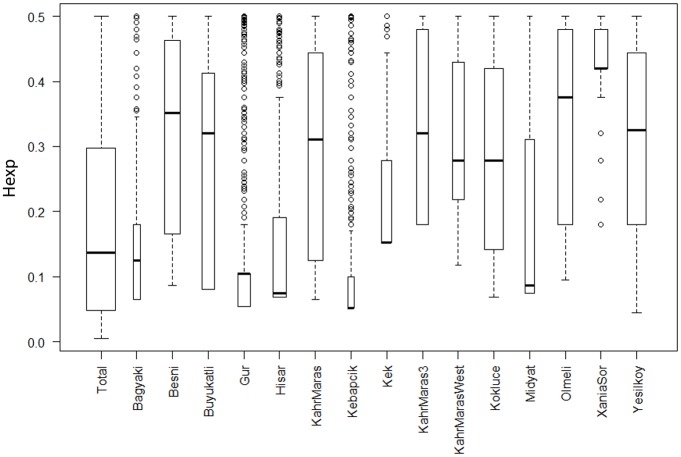
Selfing rate estimation by identity disequilibrium analysis.Black lines are value of g2 that expresses level of Identity Disequilibrium with 95% confident intervals computed using 100 bootstraps. Red bars show estimation of selfing rate based on g2 values.